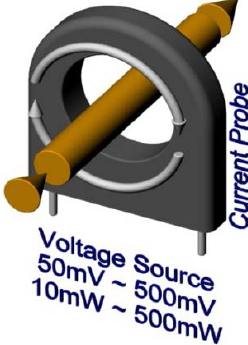
Figure 4. Current probe shape and basic